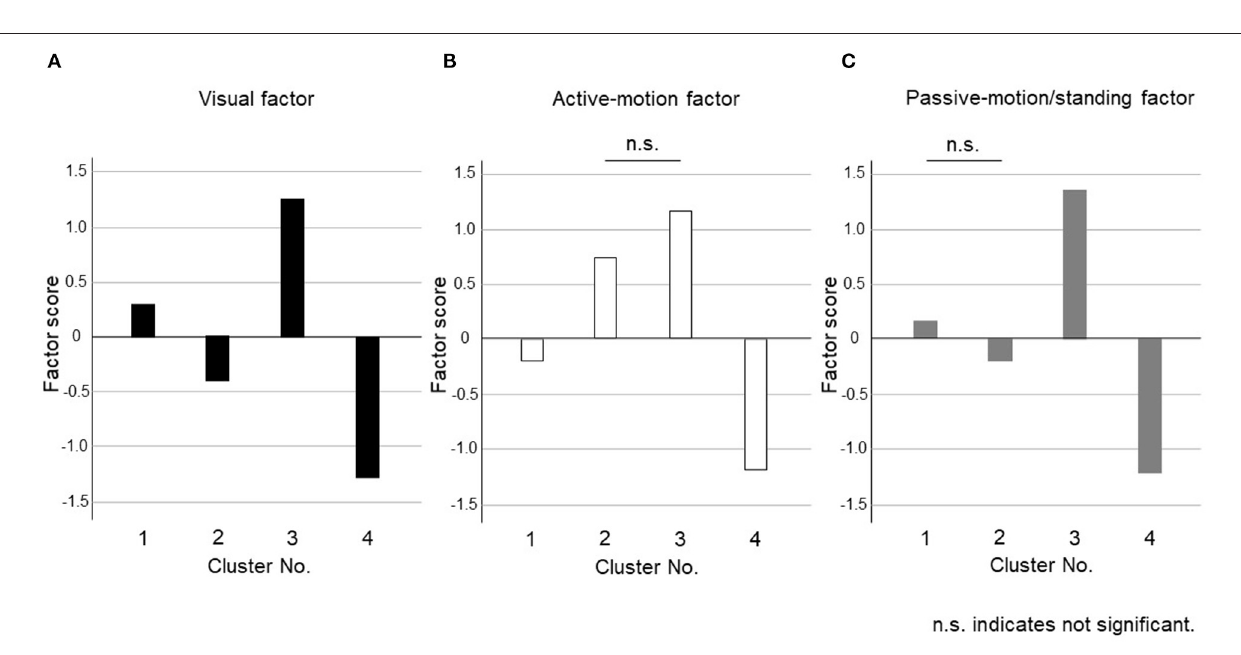
FIGURE 2 | Cluster differences assessed using the variance analysis by Tukey method for four clusters. The factor scores were shown in each cluster for (A) Visual factor, (B) Active-motion factor, and (C) Passive-motion/standing factor. The third (severe) and the fourth (mild) clusters, which were characterized by the symptom severity but not by the exacerbating factors, were combined into one cluster, which was renamed cluster